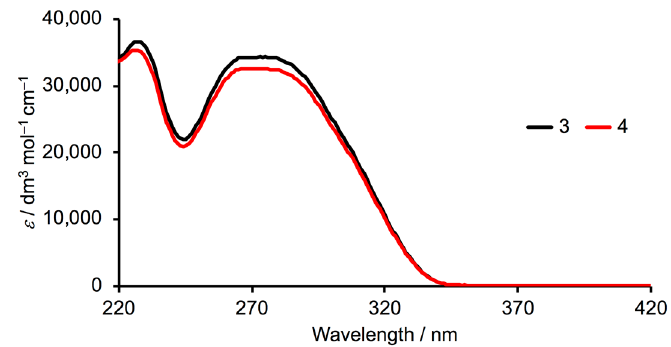
Figure 2. Solution absorption spectra of compounds 3 and 4 (MeCN, 2 × 10 –5 mol dm –3 ).